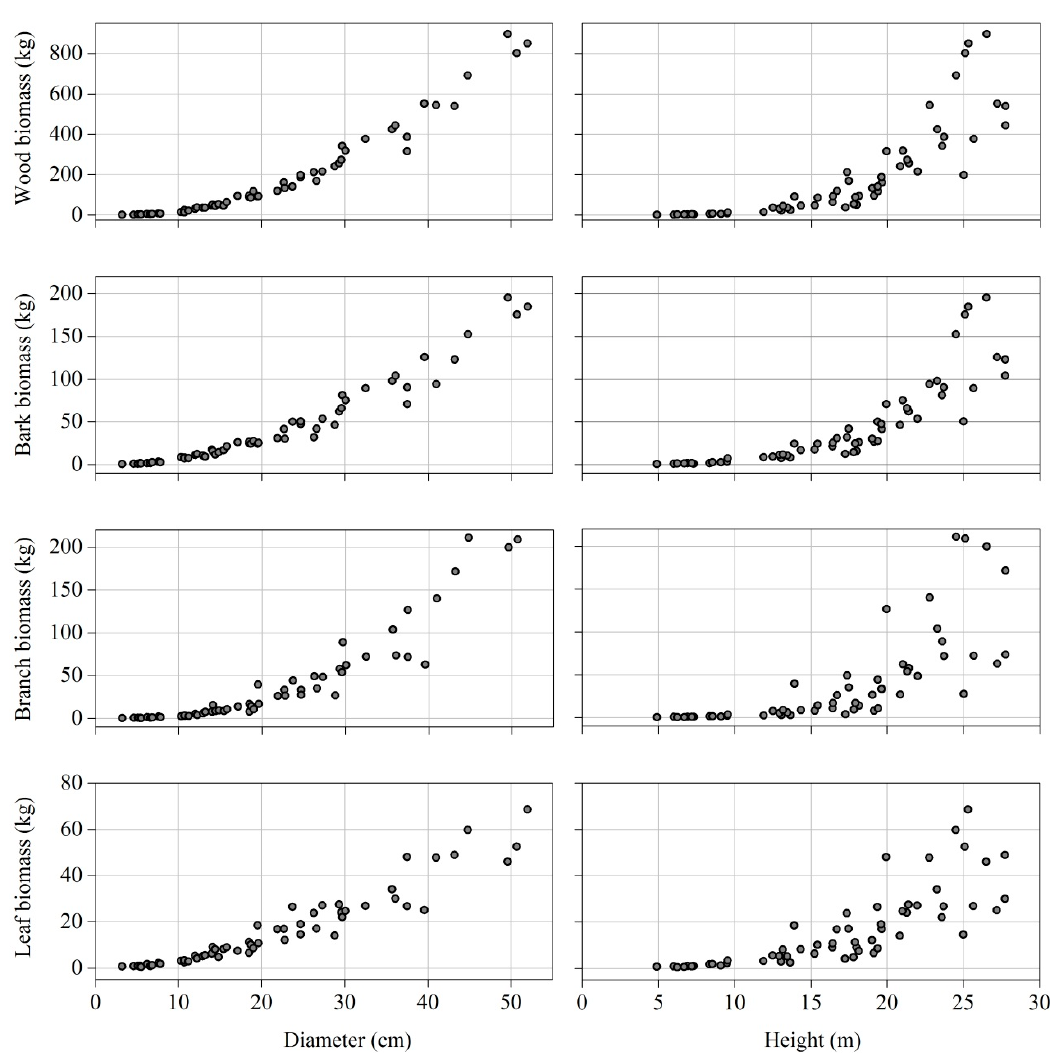
Figure 4. The relationship between wood, bark, branch, and leaf biomass and dbh and h for sampled trees. Table 4. Coefficients with standard error (SE) and goodness-of-fit statistics of the two systems of additive equations for the wood, bark, branch, and leaf components of the studied species through SUR methodology. α and β are model coefficients, while RMSE, MAE, and Adj .R 2 are the root mean square error, mean absolute error, and adjusted coefficient of determination.